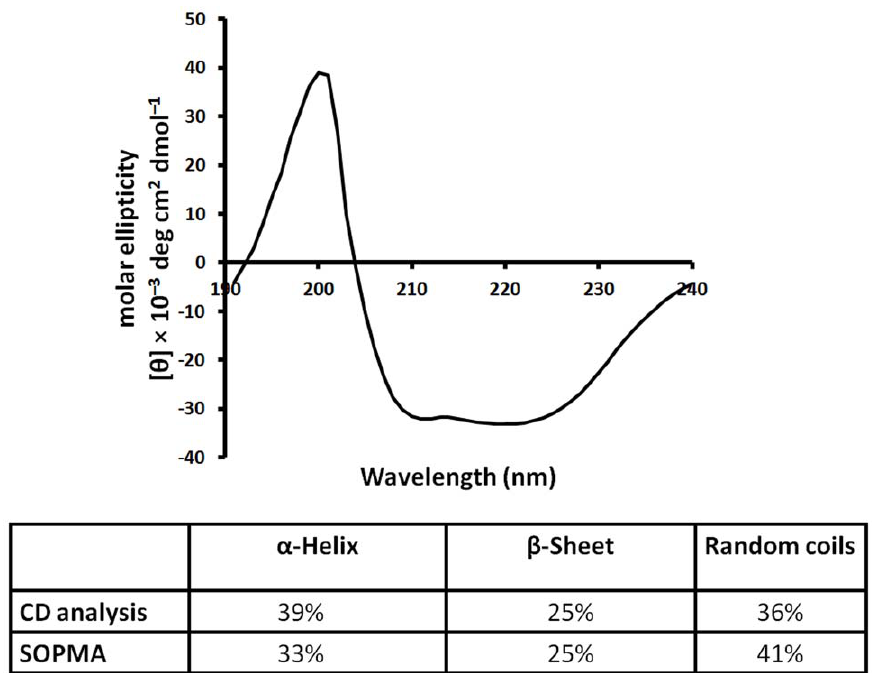
Figure 5. Circular Dichroism spectroscopy of Eh ODC. A Far-UV CD spectrum of 0.35 mg/ml Eh ODC. Data was analyzed using online K2d server for determining the secondary structure contents. Inserted table shows the comparative secondary structure content obtained by CD data analysis and SOPMA server. doi:10.1371/journal.pntd.0001559.g005 90667.295 m/z and these correspond to the monomeric and dimeric state of the protein respectively (Figure 6). Thus, it was established that Eh ODC enzyme exists in dimeric state.